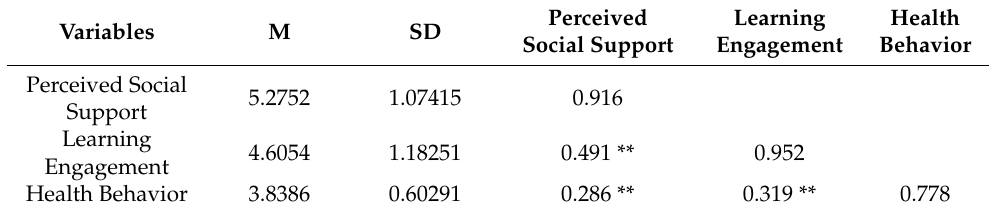
Table 3. Results of correlation analysis.